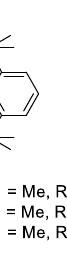
Figure 5. Amine – imine nickel complexes with different backbone substituents.